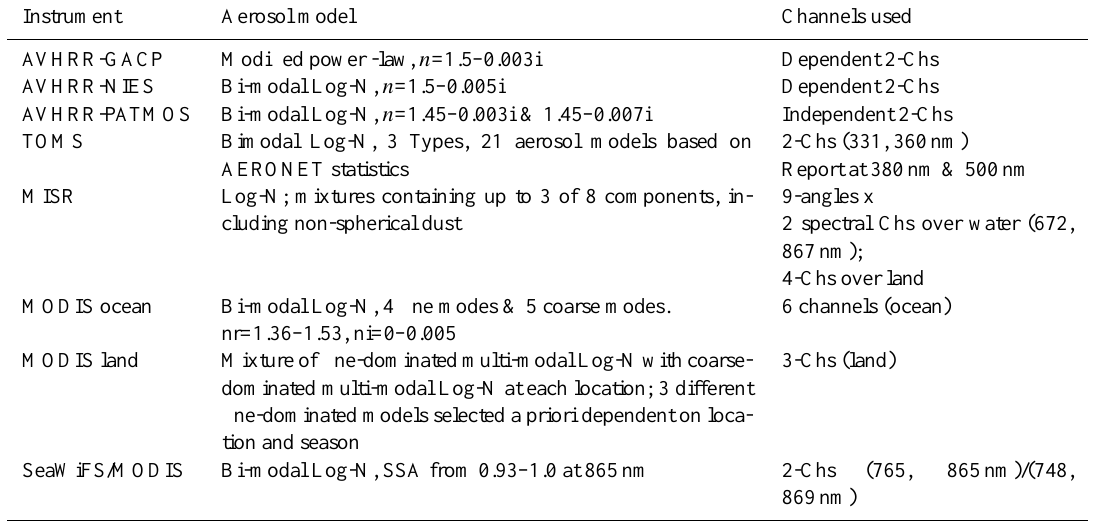
Table 3. Summary of aerosol models and instrument channels and angles used for satellite aerosol